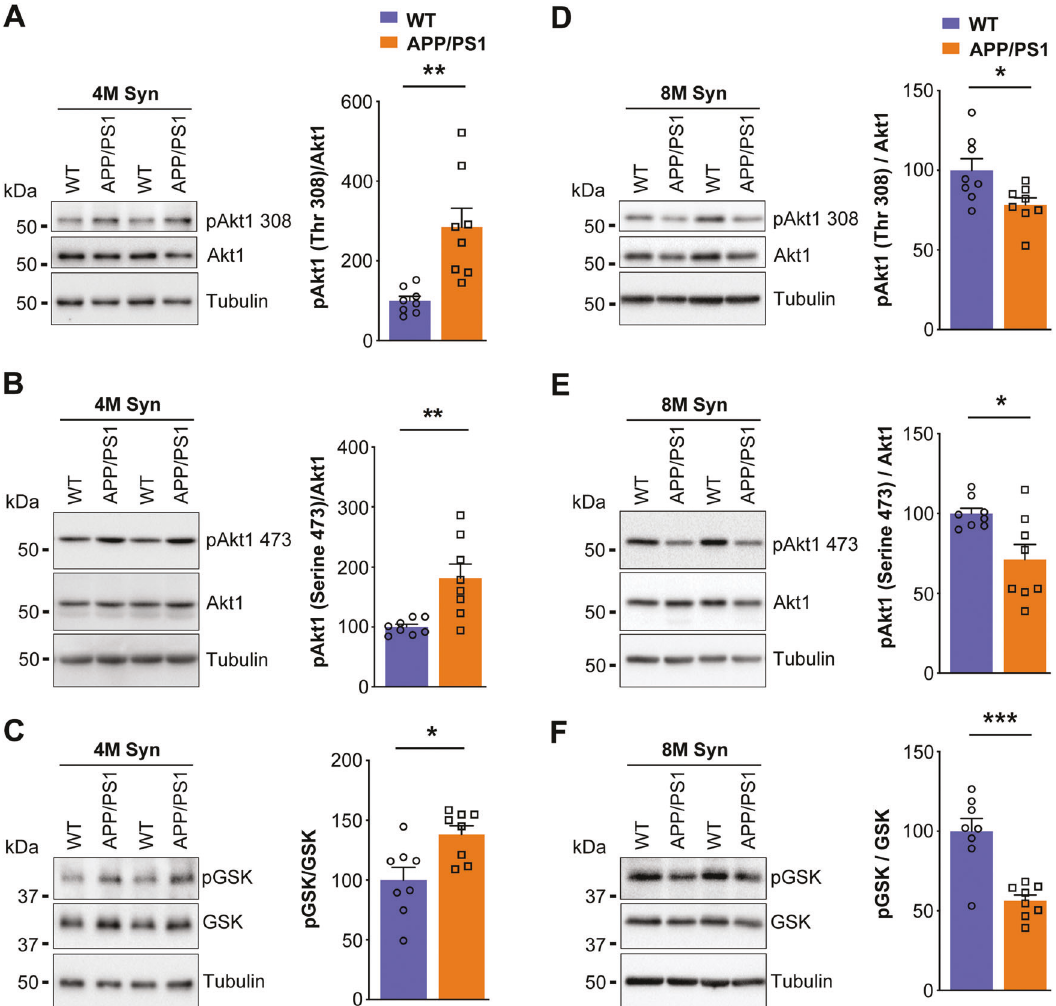
Fig. 3 Phosphorylation of Akt1 and GSK3 β is increased in synaptosomes of APP/PS1 female mice at 4 months of age while decreased at 8 months of age. Synaptosomes from 4- and 8- months old WT and APP/PS1 female mouse brain cortex were subjected to SDS-PAGE followed by western transfer and representative immunoblots were probed with ( A and D ) phospho-Akt1 (threonine-308) antibody, ( B and E ) phospho- Akt1 (serine-473) antibody, and ( C and F ) phospho-GSK3 β antibody. Subsequently, these blots were stripped and reprobed, sequentially, for Akt1, GSK3 β and tubulin, respectively. ( A , B , D and E ) The data were quanti fi ed by measuring phosphorylated Akt1/Akt1 (( A ) t = 3.801; df = 14; p = 0.0019; Hedges ’ g (95% CI) 1.79 (0.63, 2.91), ( B ) t = 3.479; df = 14; p = 0.0037; Hedges ’ g (95% CI) 1.64 (0.51, 2.72), ( D ) t = 2.555; df = 14; p = 0.0229; Hedges ’ g (95% CI) − 1.20 ( − 2.21, − 0.16), ( E ) t = 2.877; df = 14; p = 0.0122; Hedges ’ g (95% CI) − 1.36 ( − 2.39, − 0.28)), ( C and F ) phosphorylated-GSK3 β /GSK3 β (( C ) t = 2.958; df = 14; p = 0.0104; Hedges ’ g (95% CI) 1.39 (0.32, 2.43), ( F ) t = 4.977; df = 14; p = 0.0002; Hedges ’ g (95% CI) – 2.35 ( − 3.59, − 1.06)) band intensity ratios and Akt1, GSK3 β , and tubulin band intensities were quanti fi ed using Bio-Rad image lab software 5.1. Statistical analysis: Two-sided, t-test was used for comparison between WT versus APP/PS1 mouse groups. Data are presented